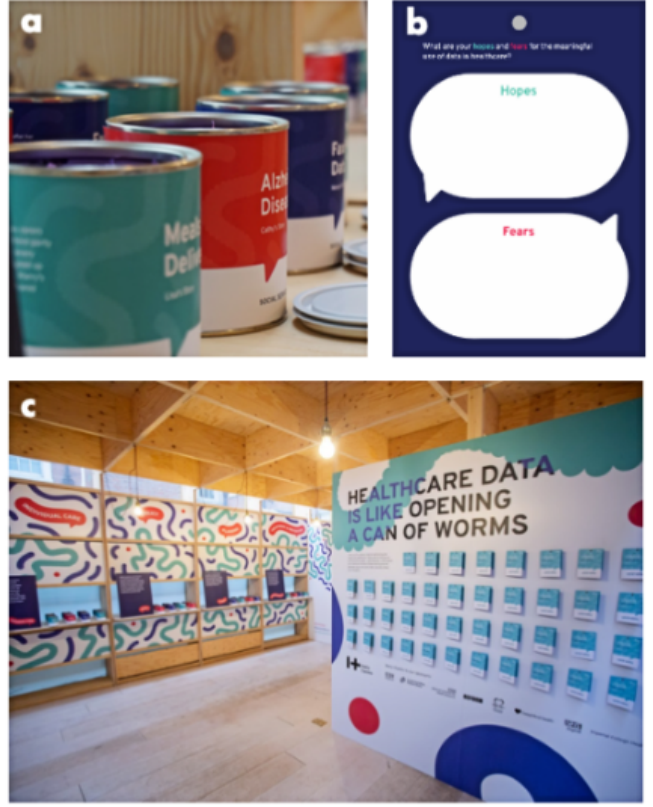
Figure 1. Materials used in the Can of Worms events. (a) Cans containing audio stories focusing on a particular aspect of healthcare data sharing. (b) Blank response card used to collect participants' hopes and concerns towards data sharing. (c) Overview of the Can of Worms public engagement immersive